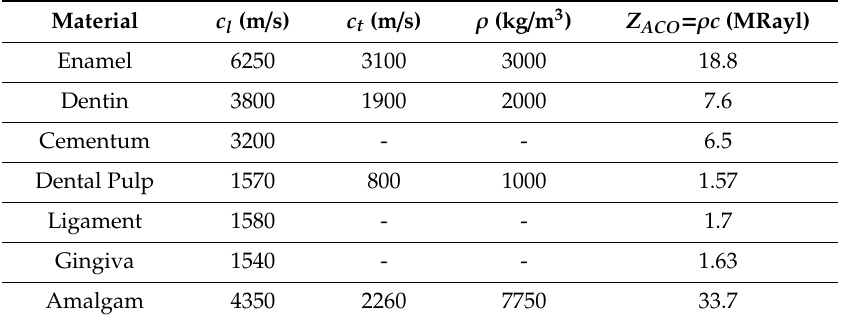
Table 6. Acoustic properties of typical dental media. c l and c t represent the longitudinal and transverse wave velocity [449,452,453].